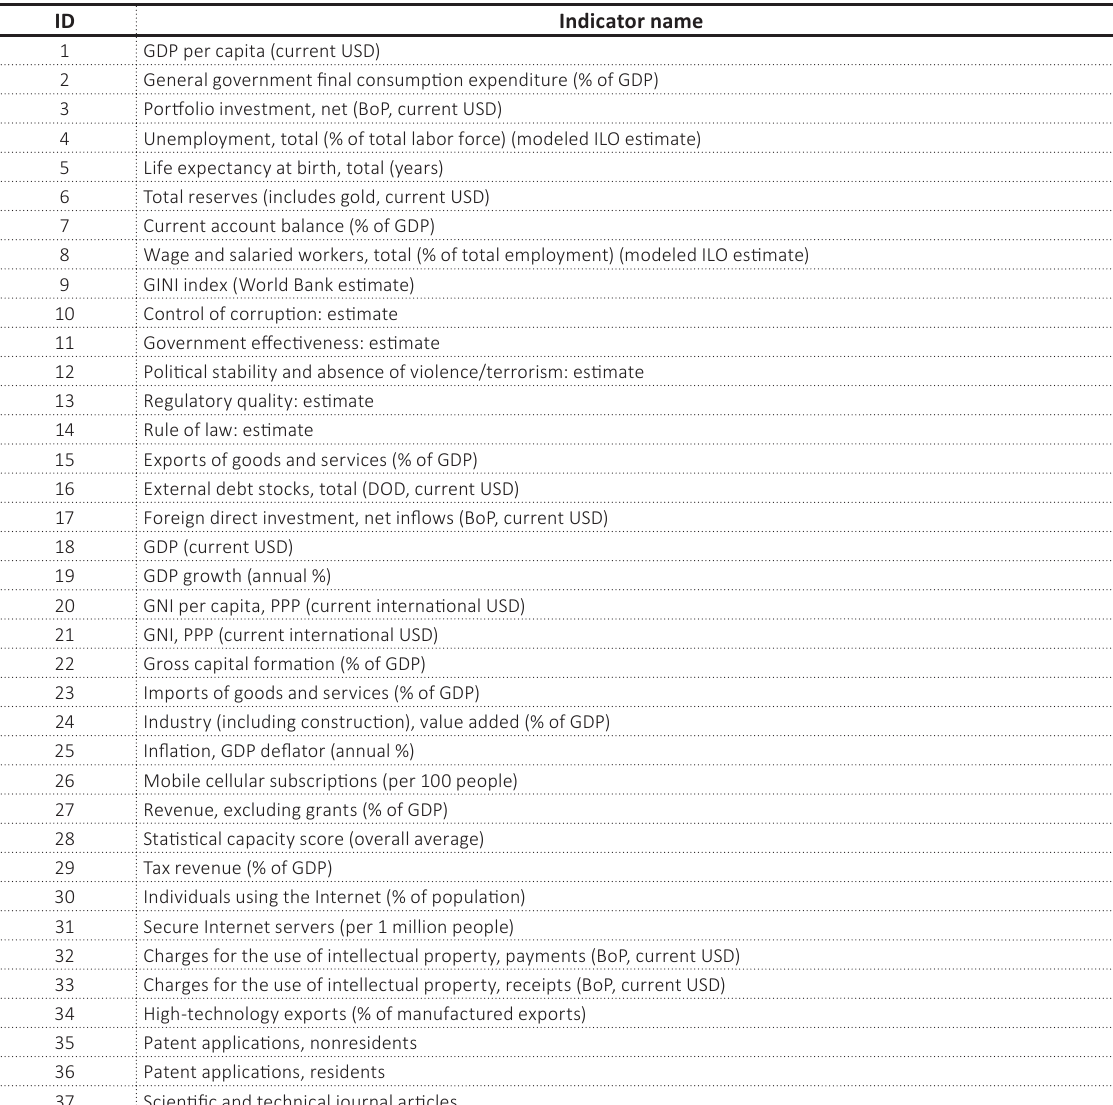
Table 1A. World Development